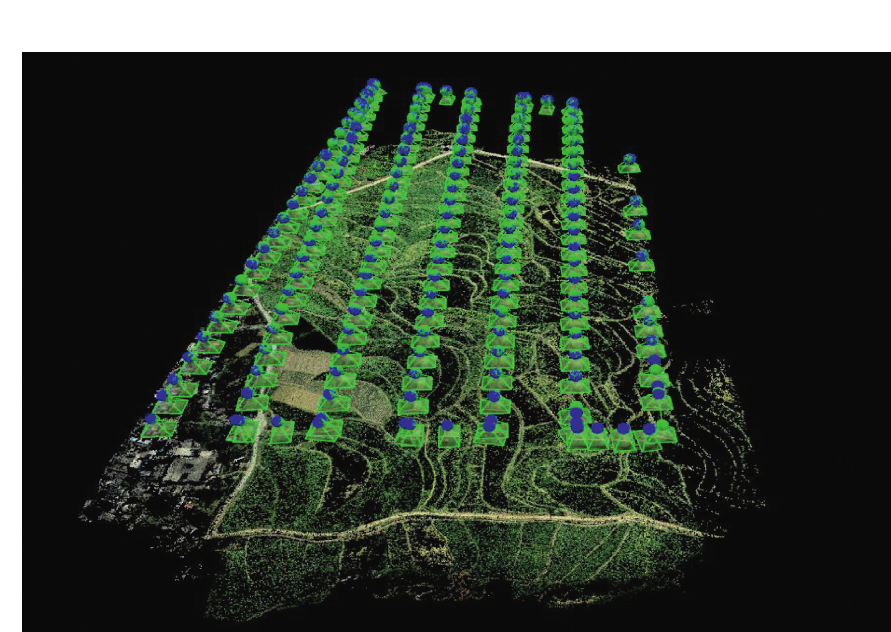
Figure 2: Design of flight belt.